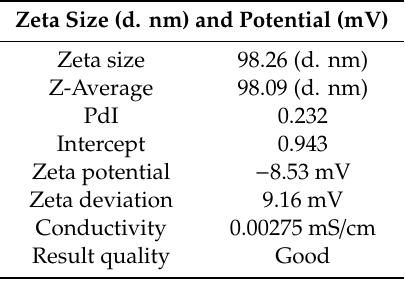
Table 1. Zeta potential measurements of the